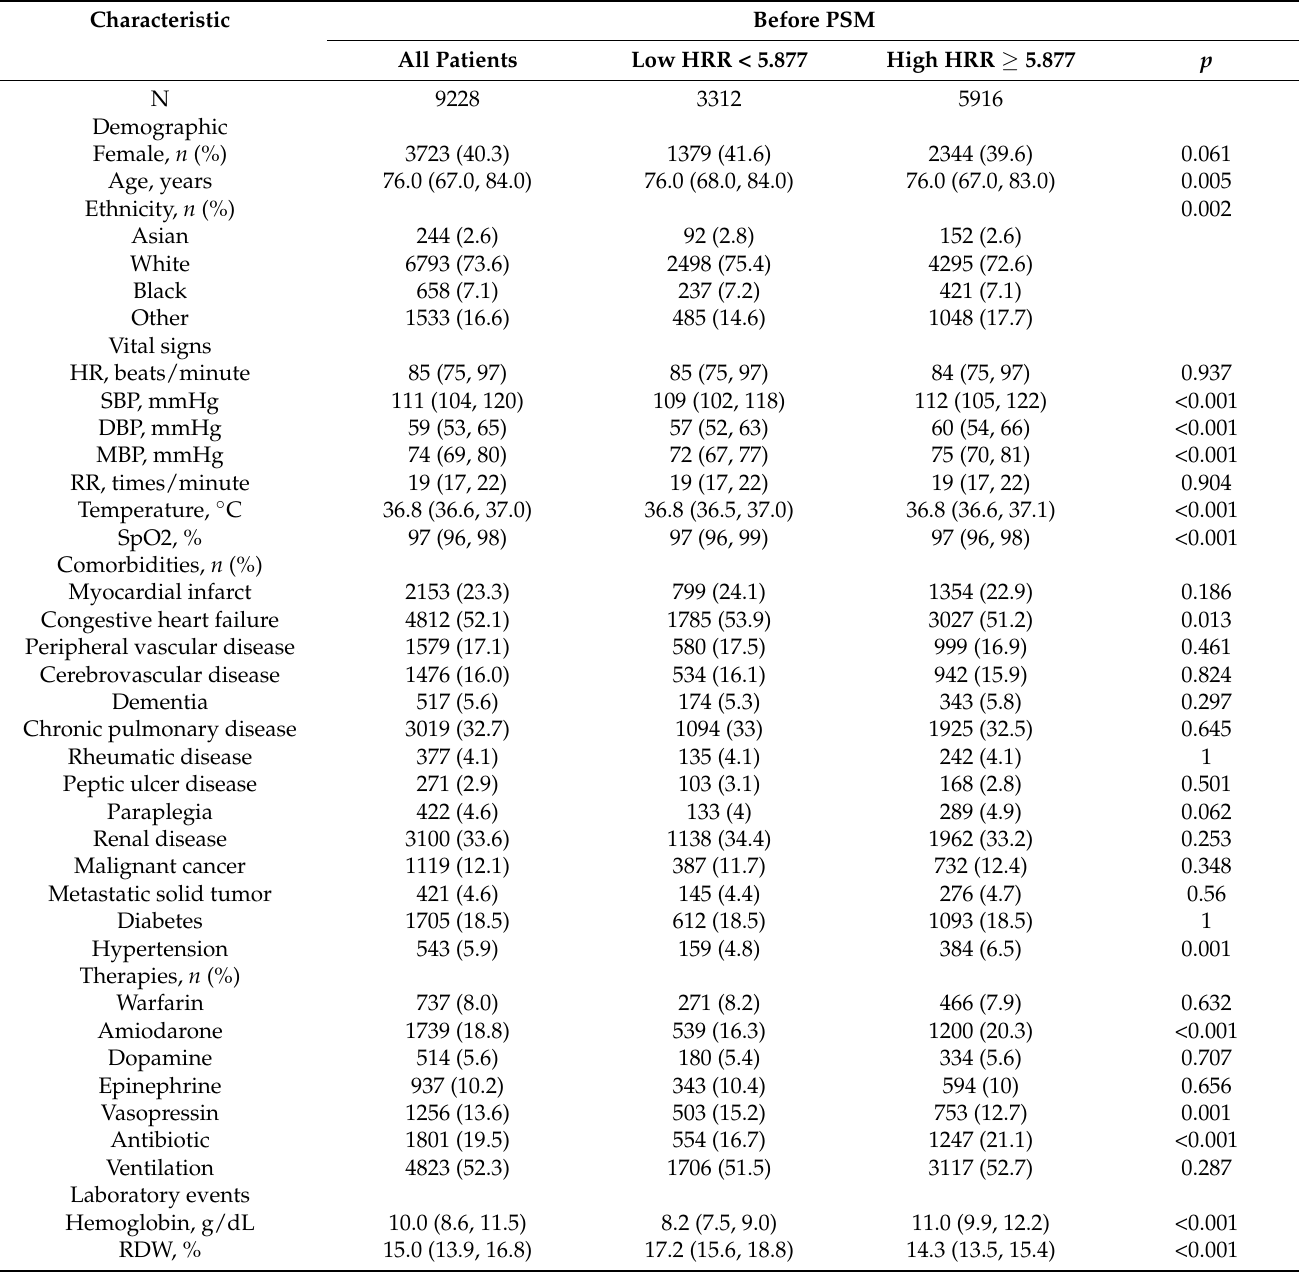
Table 2. The clinical characteristics of septic patients with atrial fibrillation before